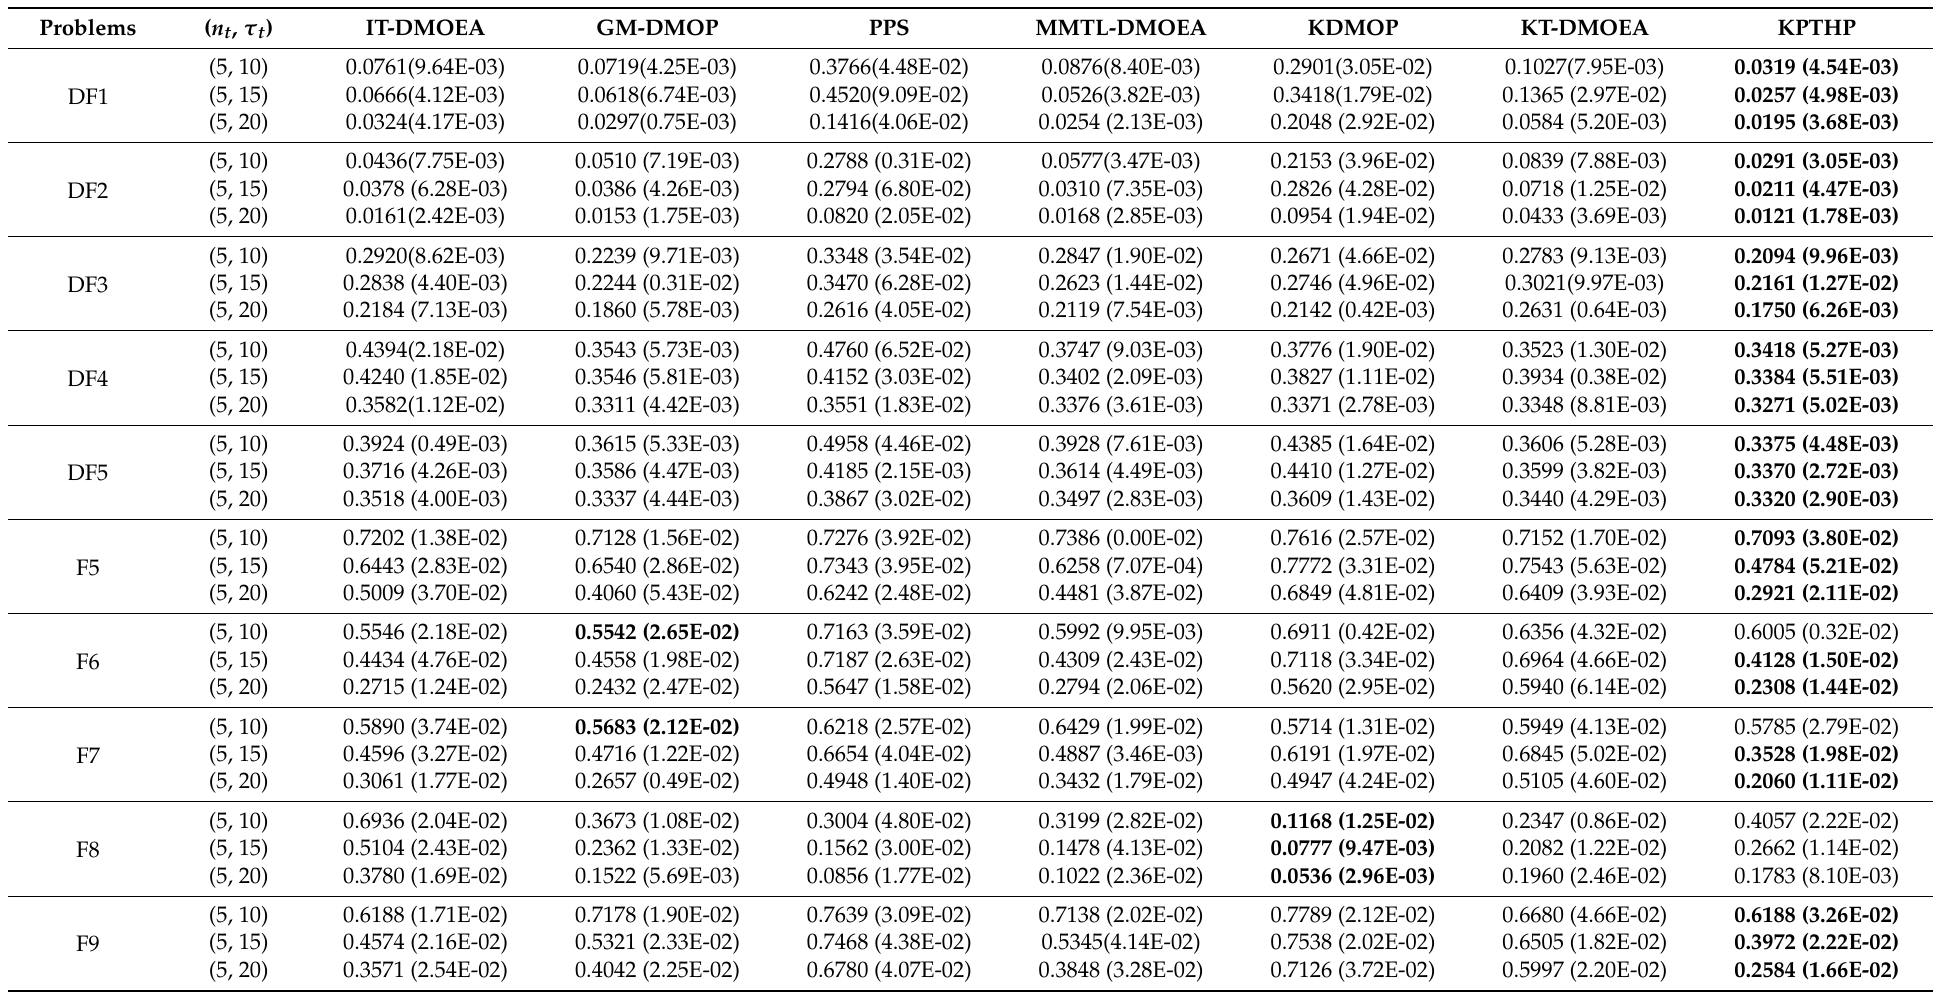
Table 7. Mean and SD of HVD indicator obtained by seven algorithms for ( n t , τ t ) = (5,10), (5, 15), and (5, 20).